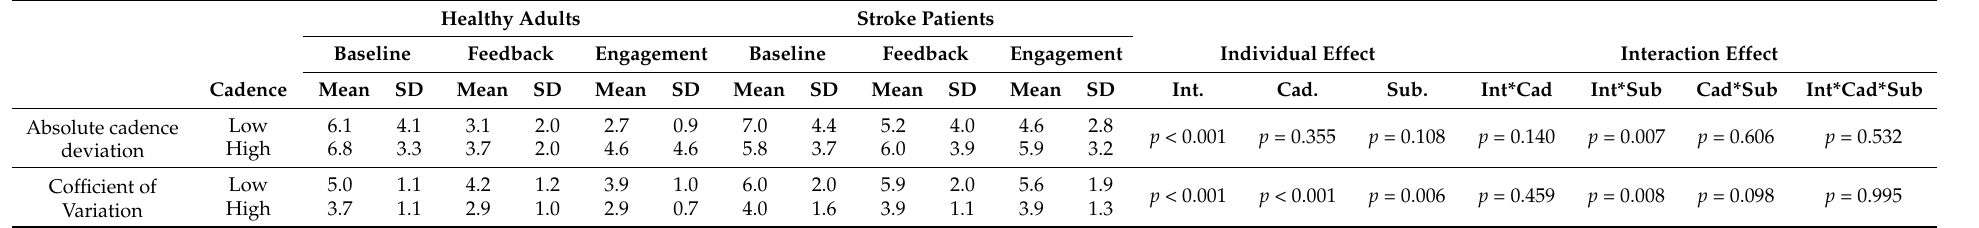
Table 1. Results of the three-way analysis of variance (ANOVA) for the cadence control parameters during pedalling at low and high speeds. The dependent variables were absolute cadence deviation from the target cadence (RPM) and the coefficients of variation (%) of the cadence deviation. The independent variables were intervention type (baseline pedalling, pedalling with performance feedback, and pedalling with video-based engagement), low and high pedalling speed (60 RPM and 100 RPM, respectively), and participant type (healthy adults or stroke patient). For each variable, mean and standard deviation (SD) are reported. Significant differences in intervention type (Int), pedalling cadence (Cad), subject type (Sub), and their interactions are given, specifically, Int*Cad, Int*Sub, Cad*Sub, and Int*Cad*Sub. See Supplementary Materials for effect size